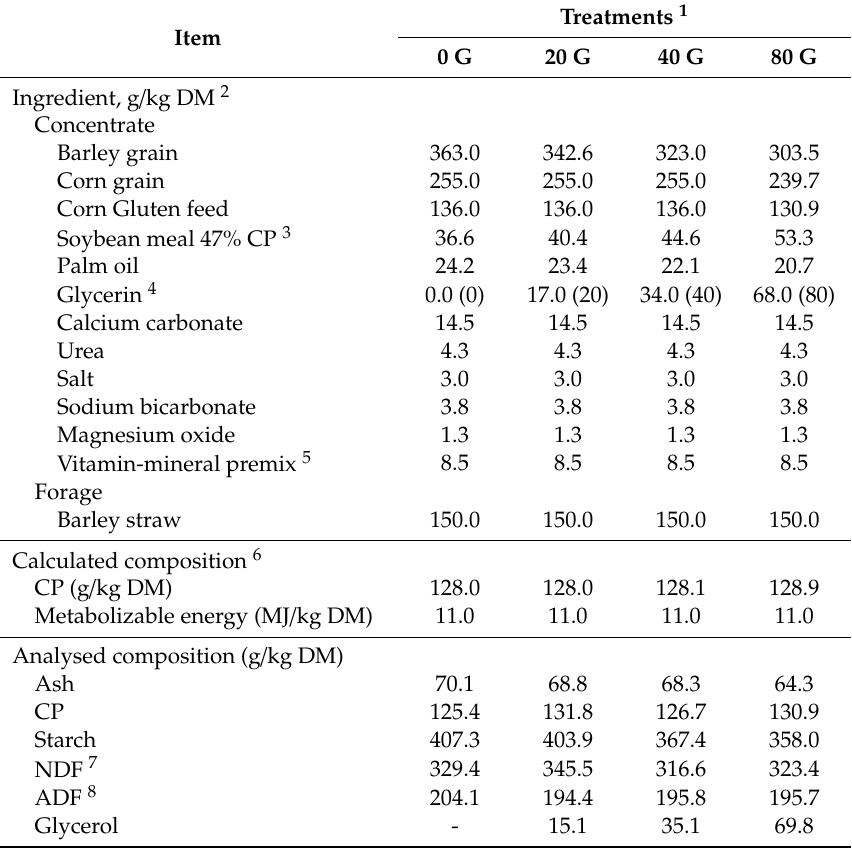
Table 1. Ingredients and composition of the experimental